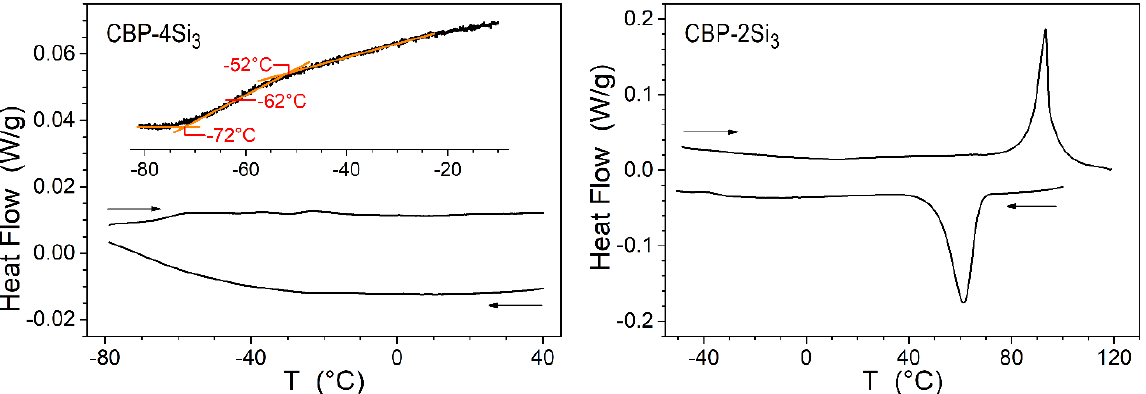
Figure 3. Differential scanning calorimetry (DSC) thermograms of the silylated compounds 14a ( CBP4Si 3 ) and 14b ( CBP- 2Si 3 ) recorded on heating and cooling at 2 °C/min for 14a and at 5 °C/min for 14b (endotherm up); inset view: modulated DSC thermogram of the glass transition range of 14a (modulation period: 40 s; amplitude: ±0.106 °C; ramp: 0.1 °C/min; ordinate: reversing heat flow, endotherm up). CBP-4Si 3 is a liquid with the glass transition located at −62 °C whereas CBP- 2Si 3 is a solid melting at 87 °C and crystallizing again from liquid on cooling.